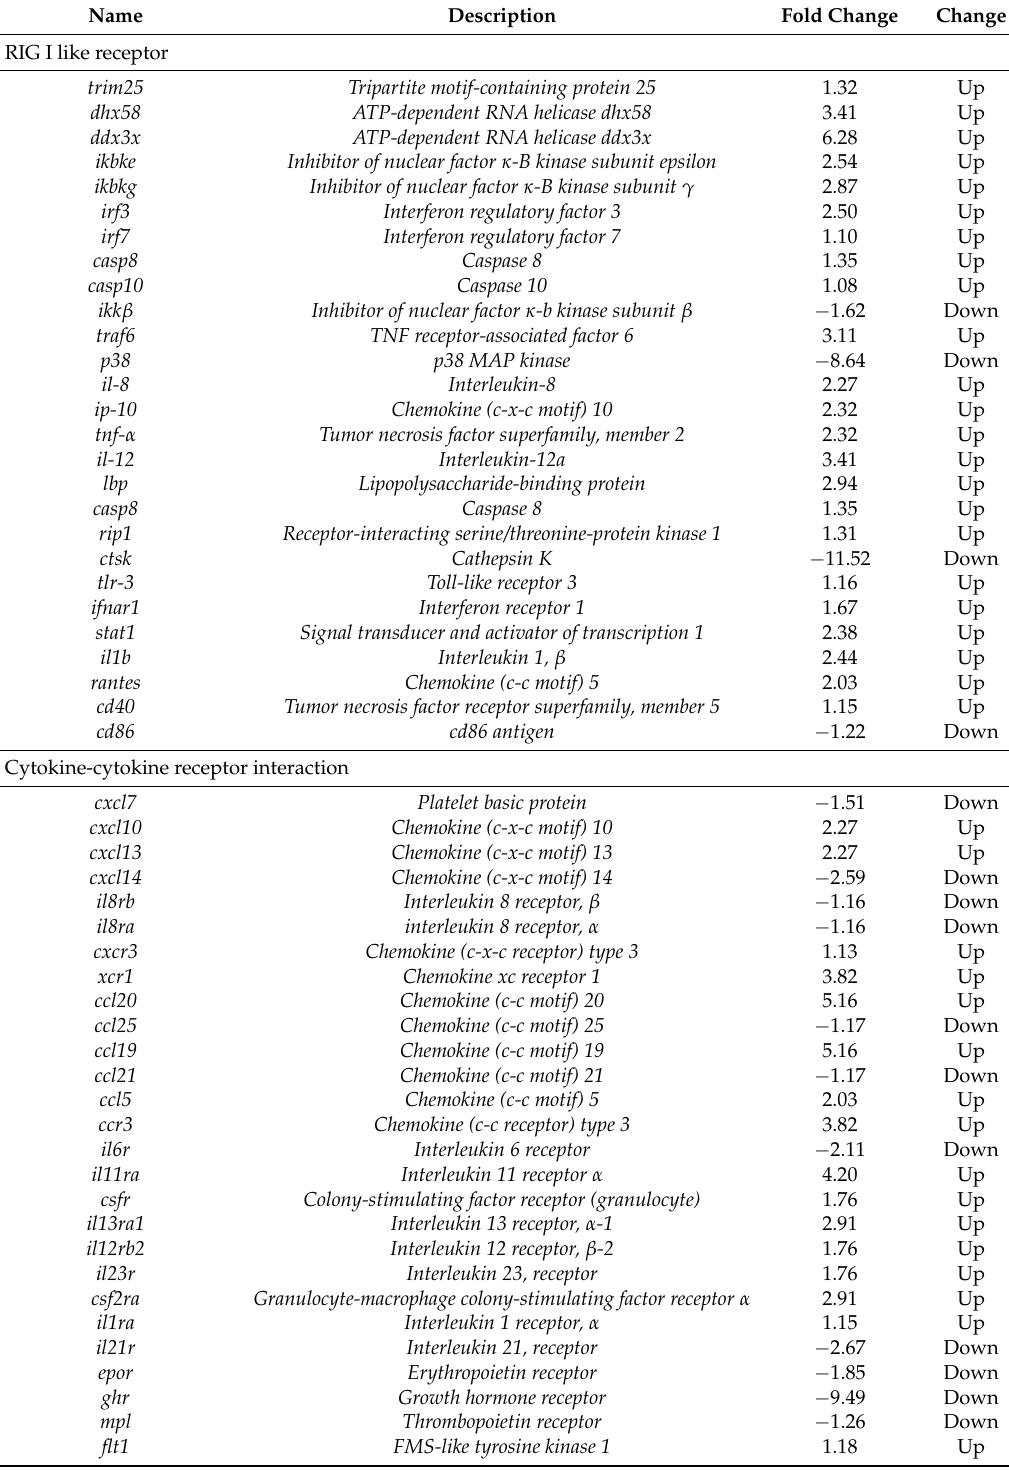
Table 1. Immune-related differentially expressed genes (DEGs) regulated after